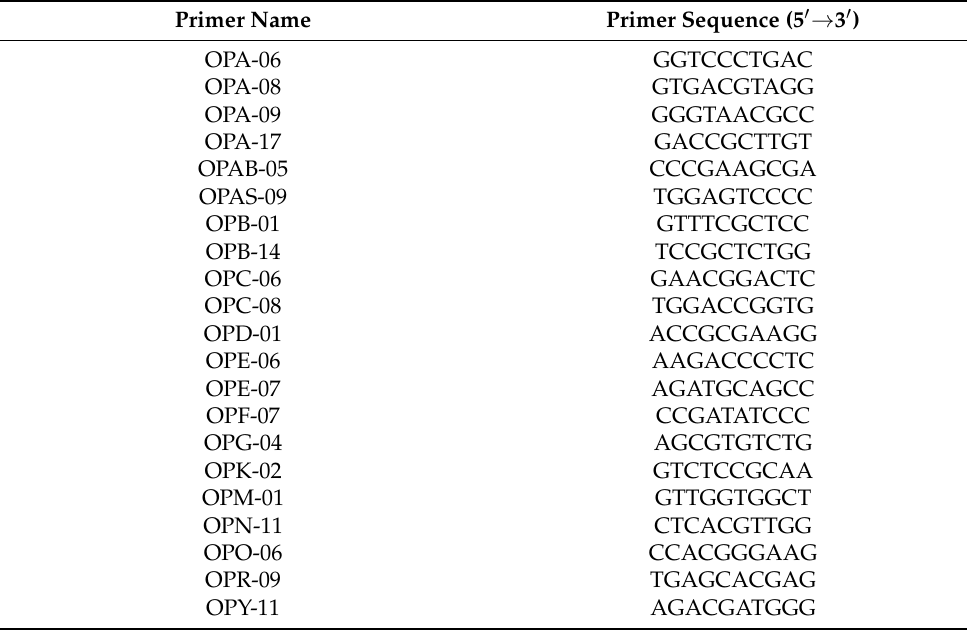
Table 2. Random amplified polymorphic DNA primers used in this